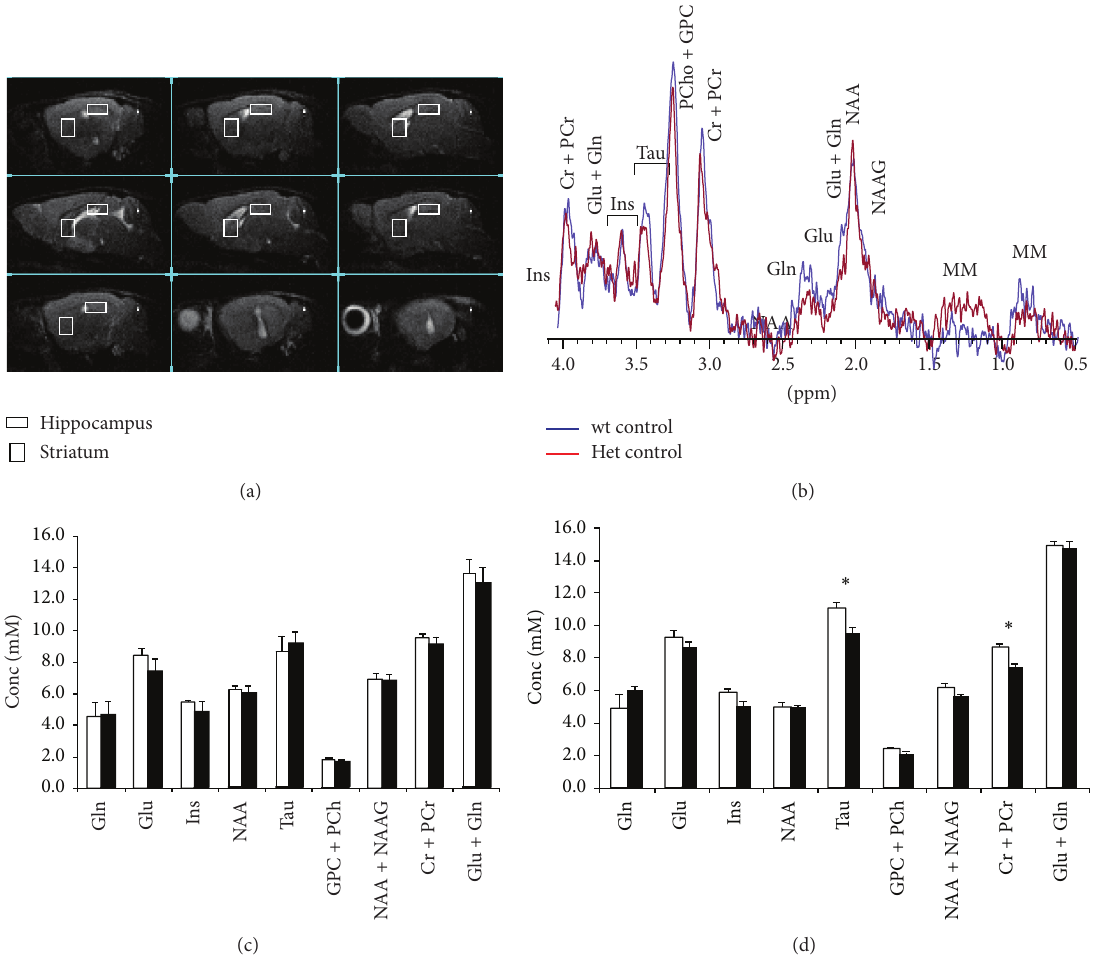
Figure 5: Brain metabolic profile. (a) Examples of in vivo sagittal T2-weighted spin-echo MR images (TR/TEeff = 3000/60 ms, slice thickness 0.8 mm, ns = 4, 13 slices, FOV = 25 × 25 mm 2 , and matrix 256 × 256). (b) Example of in vivo 1 H MR spectra (PRESS, TR/TE = 4000/23 ms, NS = 256) acquired from a voxel positioned in the striatum (indicated by the white rectangles in (a)) of a wild-type (wt) and MeCP2-308 female mice (Het). (c) and (d) Metabolite levels obtained from in vivo 1 H spectra in the hippocampus (c) and the striatum (d), obtained by using a quantitative protocol (which uses water as internal standard) and LCModel fitting program. Metabolite assignments: Cr, creatine; Gln, glutamine; Glu, glutamate; GPC, glycerophosphocholine; Ins, myo-inositol; NAA, nacetylaspartate; NAAG, n-acetylaspartylglutamate; PCho, phosphocholine; PCr, phosphocreatine; Tau, taurine. Data are expressed as mean ± SEM. ∗ 𝑃 < 0.05